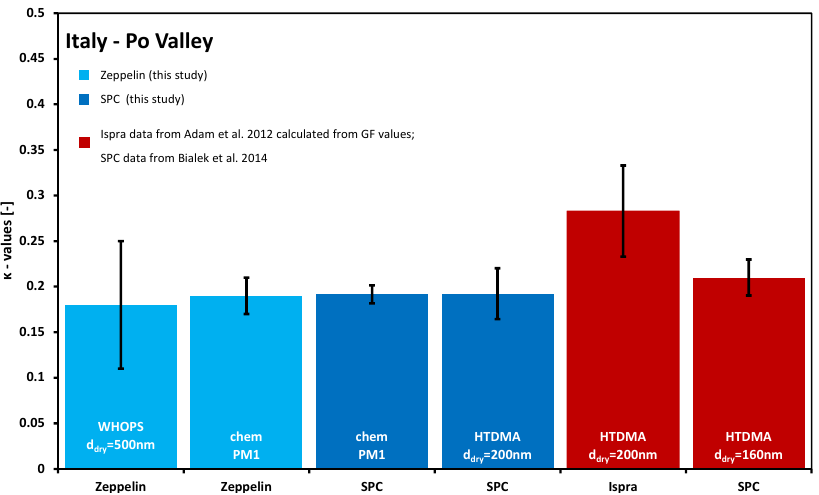
Figure 8. Inter-comparison of mean κ values measured during this study in the Po Valley on 20 June 2012 (blue bars) compared with literature data from this area (red bars). κ values are either derived from measured hygroscopic growth factors or chemical composition. Only results for the fully developed ML, when vertical gradients of aerosol properties are minimal, are included in the averages. This ensures comparability between the measurements taken at different altitudes. The error bars indicate the temporal variability of the observed κ values